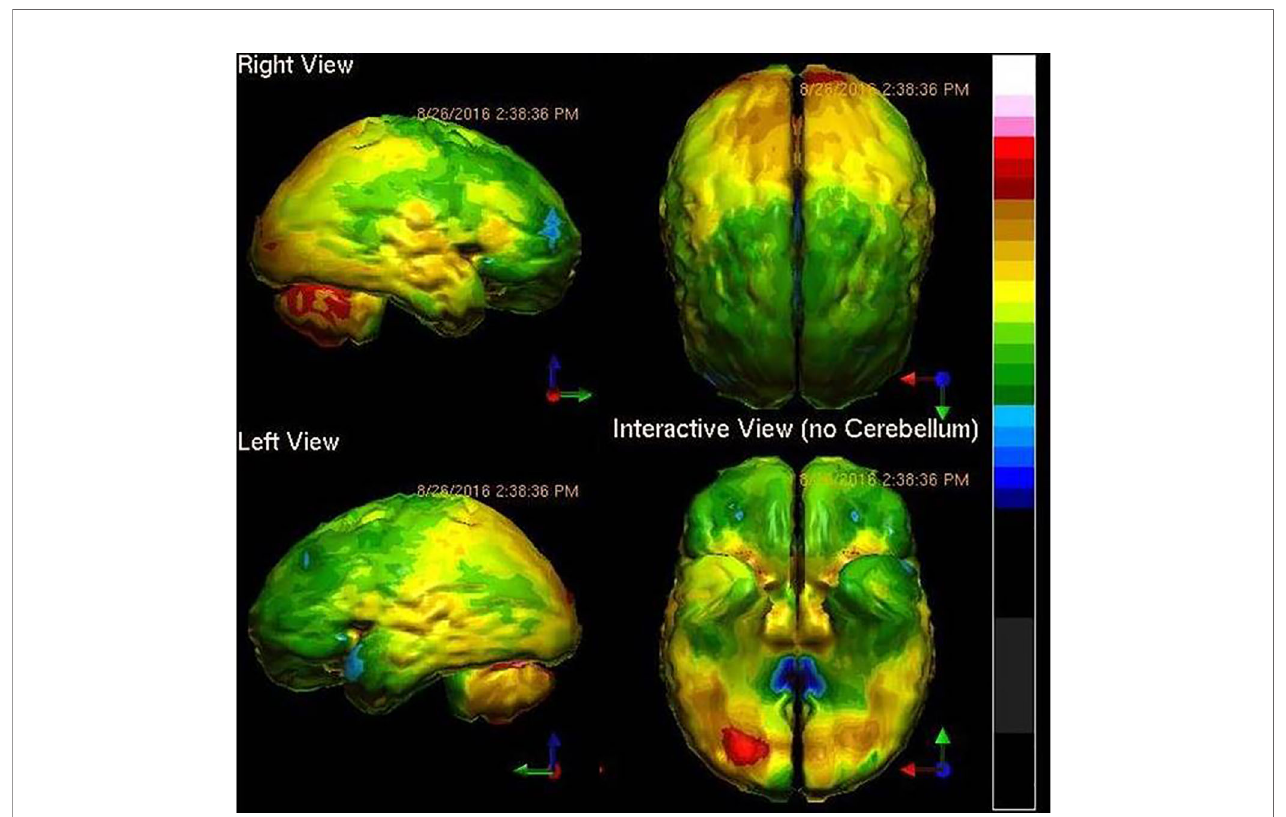
FIGURE 2 | Tc-99m-HMPAO perfusion SPECT scan data presented in surface rendering. The color scale is as in Figure 1 . Bilateral frontal and temporal hypoperfusion (green and blue) is clearly evident and is consistent with traumatic brain